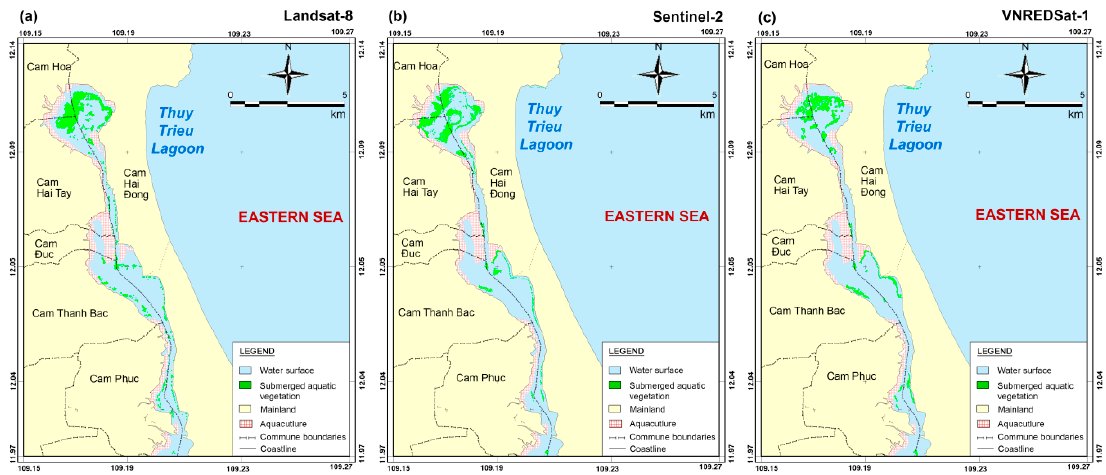
Figure 9. SAV distribution maps for Thuy Trieu Lagoon, using data from three satellites: ( a ) Landsat-8 (2018), ( b ) Sentinel-2 (2019), ( c ) VNREDSat-1 (2017).